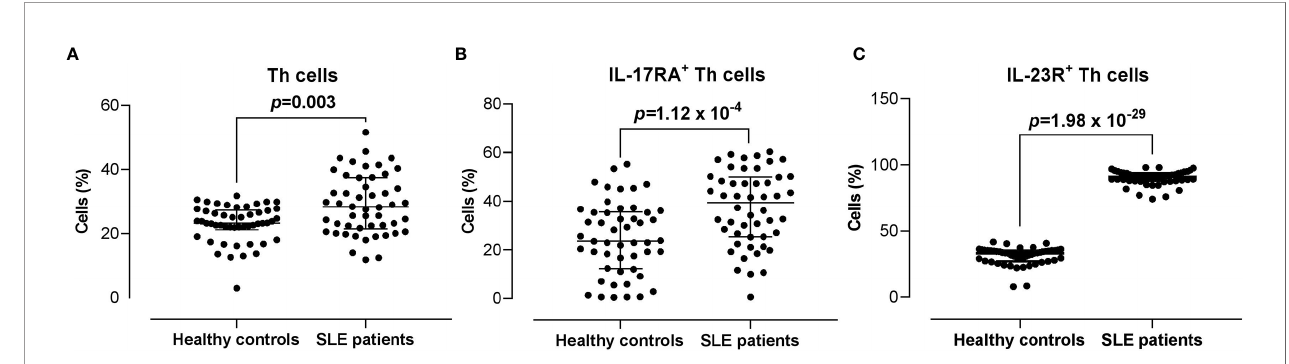
FIGURE 2 | Proportion of CD3 + CD4 + Th cells, and IL-17RA + and IL-23R + Th cells subsets in SLE patients versus healthy controls. (A) Proportion of CD3 + CD4 + Th cells in SLE patients (n = 50) vs healthy controls (n = 50). (B, C) Proportion of IL-17RA + (B) and IL-23R + (C) Th cells in SLE patients vs healthy controls. The bars in each scatter plot represent the median and interquartile